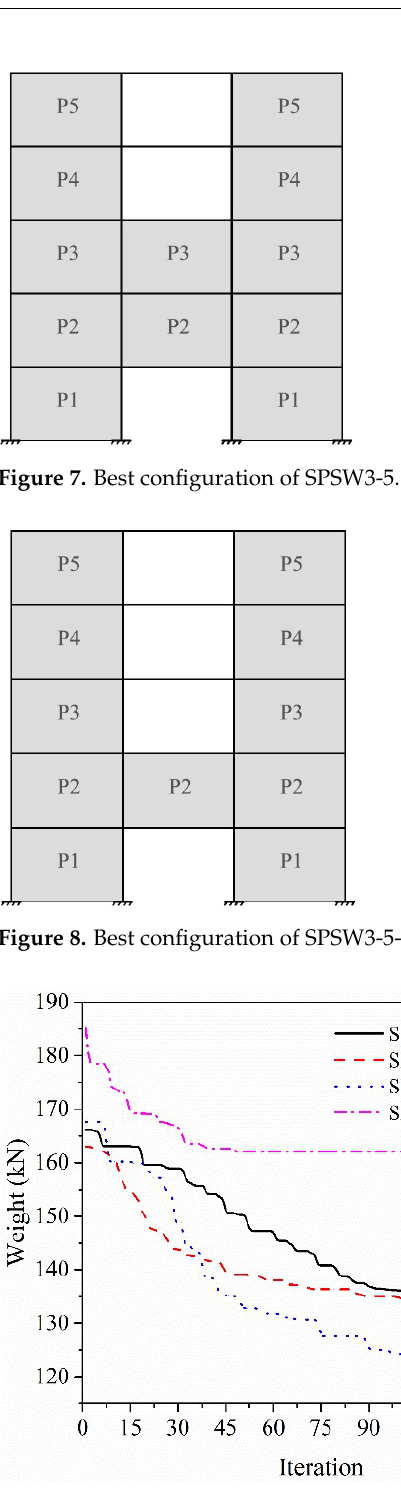
Table 6. Percentage of story shear resisted by steel plate in the optimum designs of 5-story steel frame (%).